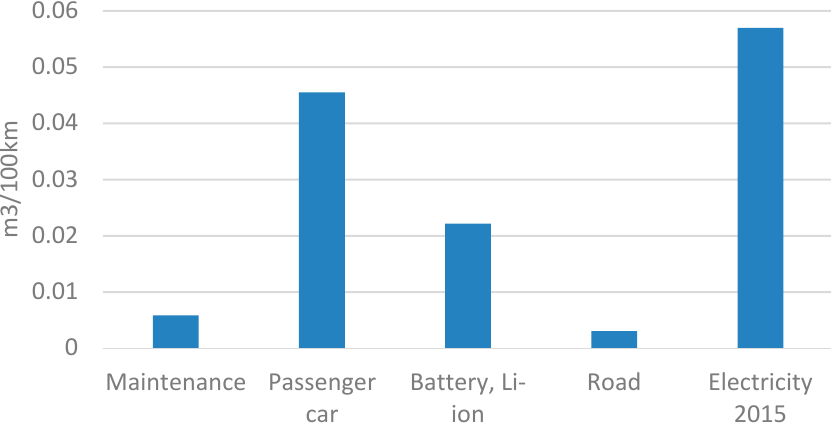
Figure 3. The carbon footprint of electric vehicles (EVs) in the Czech Republic in 2015.